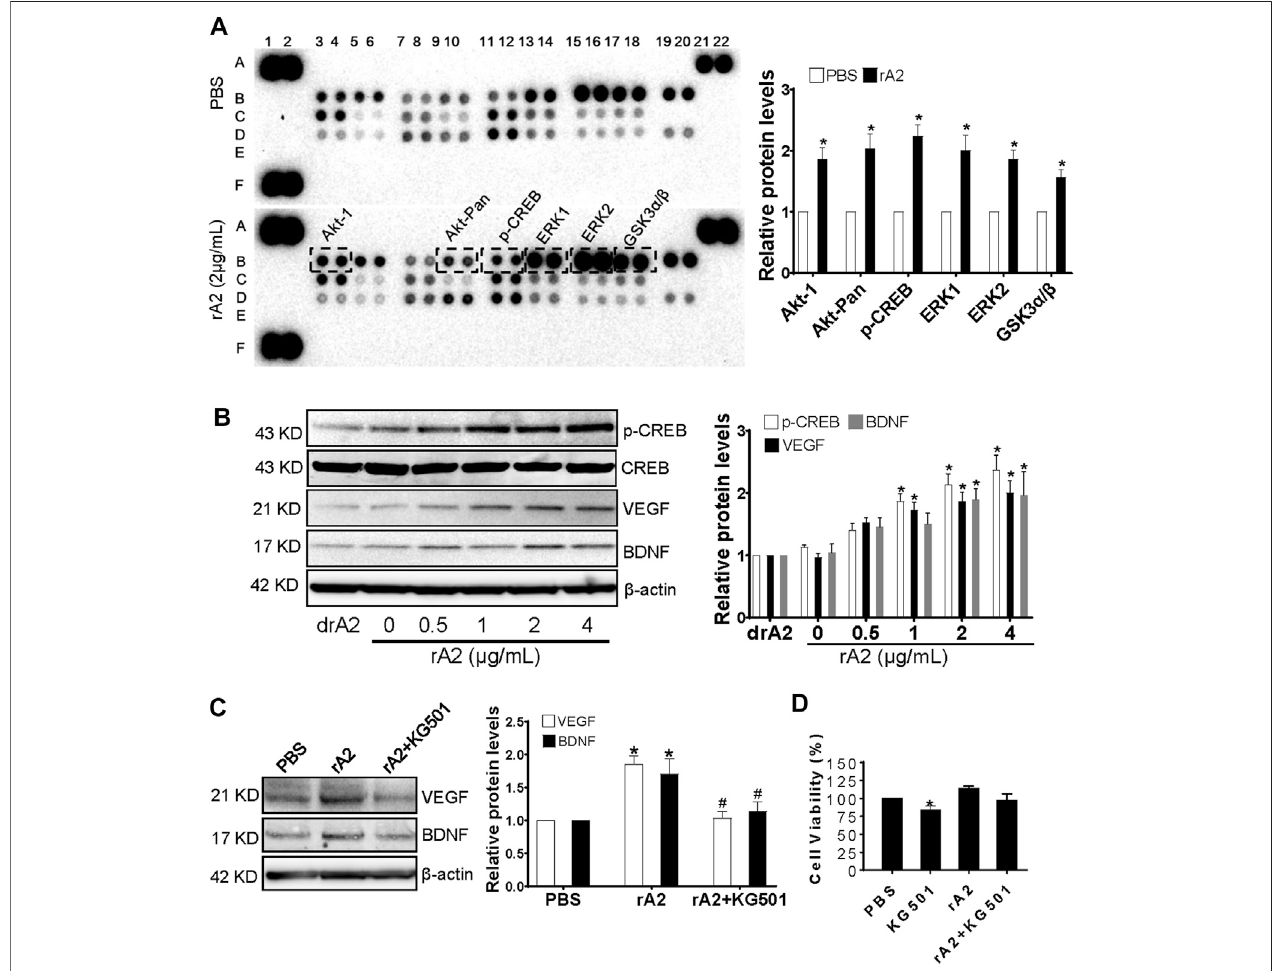
FIGURE 3 | rA2 induces CREB phosphorylation, VEGF, and BDNF in HBEMC. (A) Representative MAPKs pro fi le array and quanti fi cation in HBMEC treated with PBS or rA2 (2 μ g/ml) for 24 h, n (cid:1) 3 experiments. (B) Representative western blotting images of p-CREB, CREB, VEGF, BDNF, and β -actin and quanti fi cation for p-CREB, VEGF, BDNF in HBMEC treated with dose-dependent rA2 for 24 h n (cid:1) 3 experiments. (C) Representative gel images and quanti fi cation of western blotting for VEGF, BDNF in HBMEC treated with rA2 (2 μ g/ml) with or without KG-501 (10 μ M) for 24 h. (D) Viability of cultured HBMEC after rA2 with/without KG501 treatment. n (cid:1) 3 experiments. Data are expressed as mean ± SEM, * p < 0.05 compared to PBS, # p < 0.05 compared to